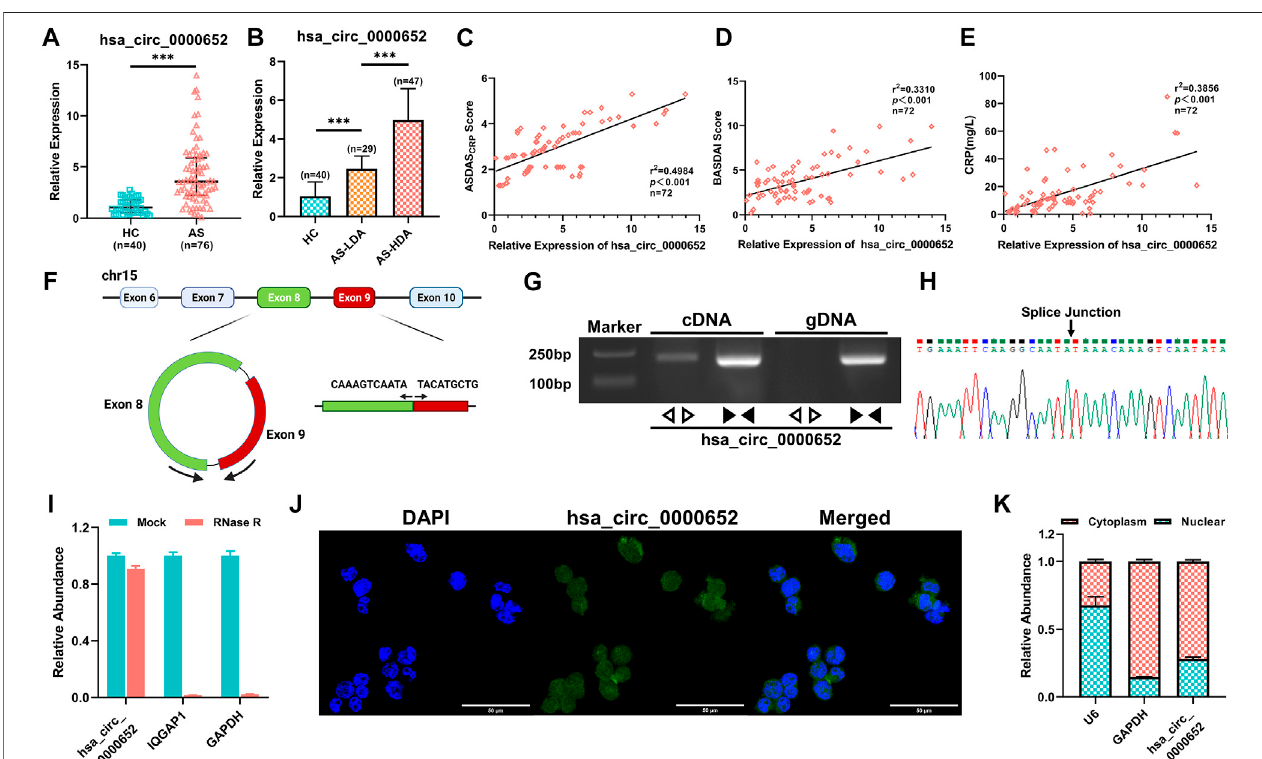
FIGURE 2 | Hsa_circ_0000652 is upregulated in PBMCs from AS patients and correlated with disease activity. (A – B) Expression of hsa_circ_0000652 in PBMCs from 76 AS patients with different disease activities and 40 healthy controls was analyzed by quantitative real-time PCR (qRT-PCR). (C – E) Correlation analysis for the expression of hsa_circ_0000652 with the Ankylosing Spondylitis Disease Activity Score (ASDAS CRP ), Bath Ankylosing Spondylitis Disease Activity Index (BASDAI), and C-reactive protein (CRP) level (mg/L) of AS patients (n (cid:2) 72). (F) Schematic illustration showing the formation of hsa_circ_0000652 from its host gene IQGAP1 by back-splicing. (G) Agarose gel electrophoresis of PCR ampli fi cation by divergent and convergent primers of hsa_circ_0000652 in cDNA and gDNA. (H) Back-splice junctionpointofhsa_circ_0000652wasidenti fi edbySangersequencing. (I) qRT-PCRanalysisofhsa_circ_0000652and IQGAP1 and GAPDH withorwithoutRNaseR treatment (n (cid:2) 3). (J – K) FISH assay and nuclear-cytoplasmic separation assay showed that hsa_circ_0000652 was mainly localized in the cytoplasm of the THP-1 cell line. Data in A and B are presented as median ± quartile and data in I and H are presented as mean ± SD. *** p < 0.001.